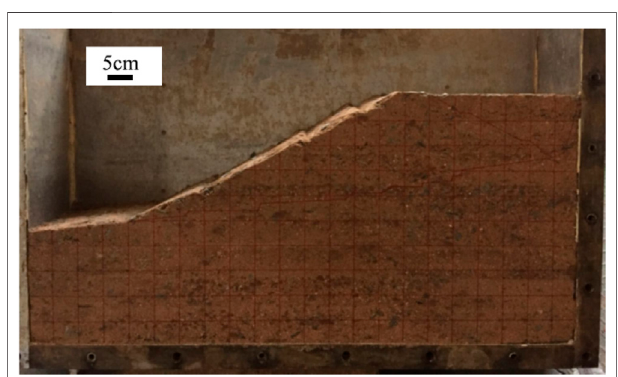
FIGURE 6 | Model of HRF embankment (before test).